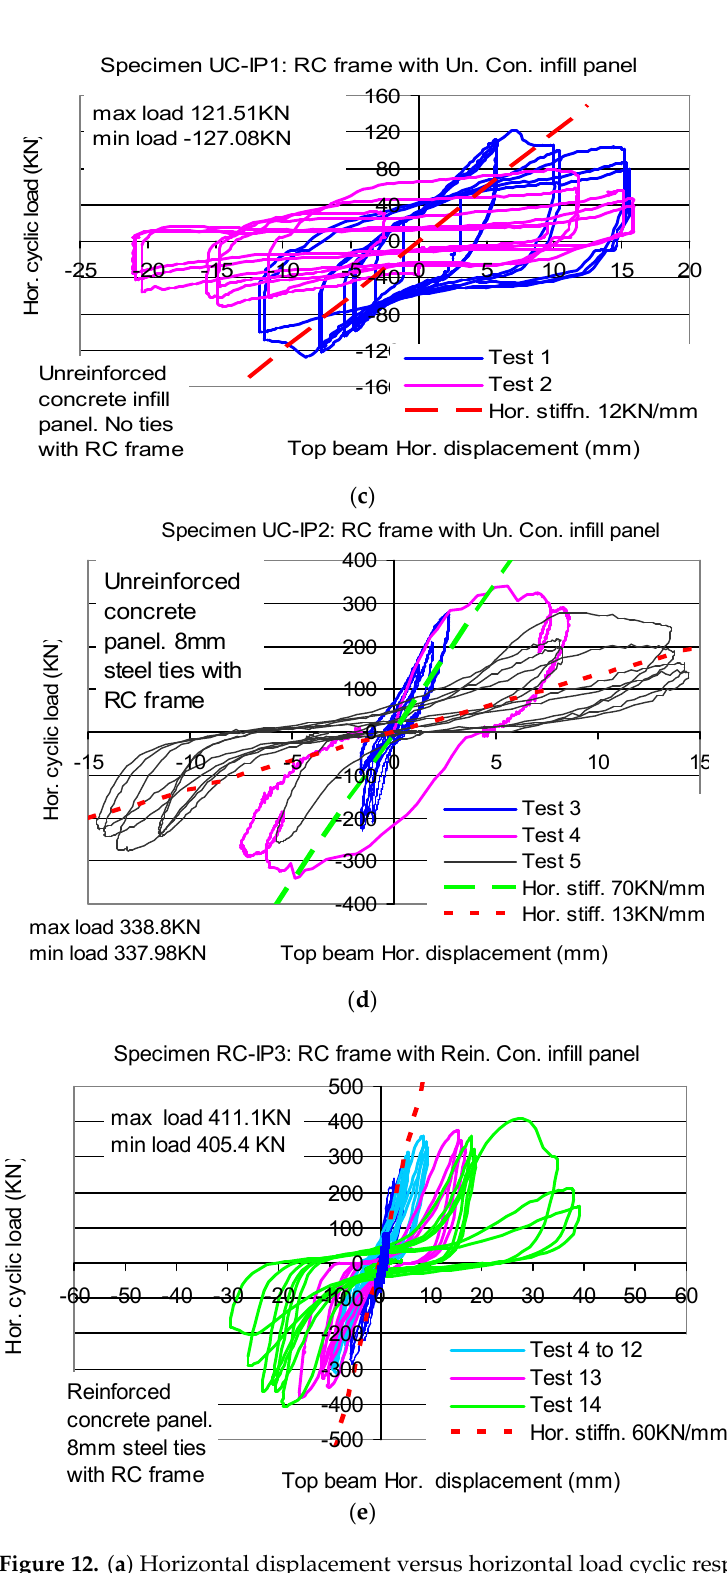
Figure 12. ( a ) Horizontal displacement versus horizontal load cyclic response of specimen Bare-1. ( b ) Horizontal displacement versus hor. load for specimens Bare Jacket1 and Bare Jacket2. ( c ) Horizontal displacement versus horizontal load cyclic response of specimen UC-IP 1. ( d ) Horizontal displacement versus horizontal load cyclic response of specimen UC-IP 2. ( e ) Horizontal displacement versus horizontal load cyclic response of specimen RC-IP